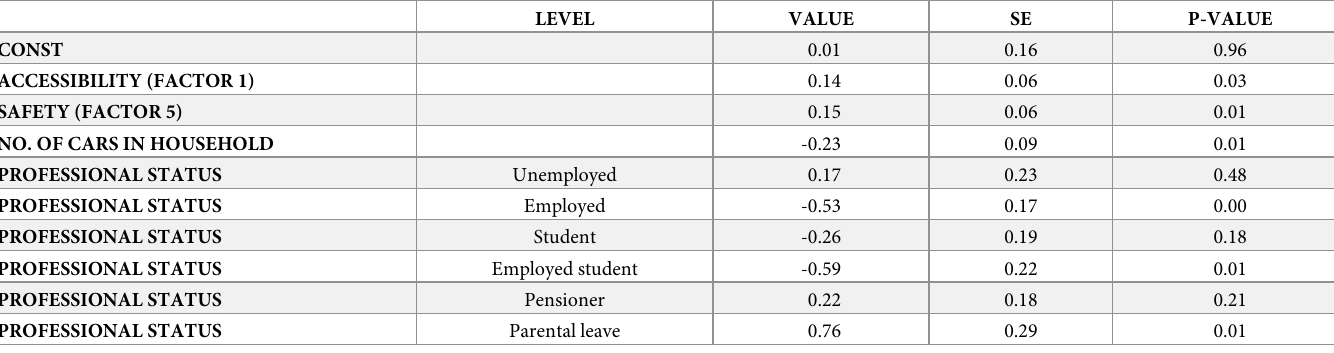
Table 5. Results of the optimal logistic regression model—Binary dependent variable (1—Walking trip, 0—Mixed trip).